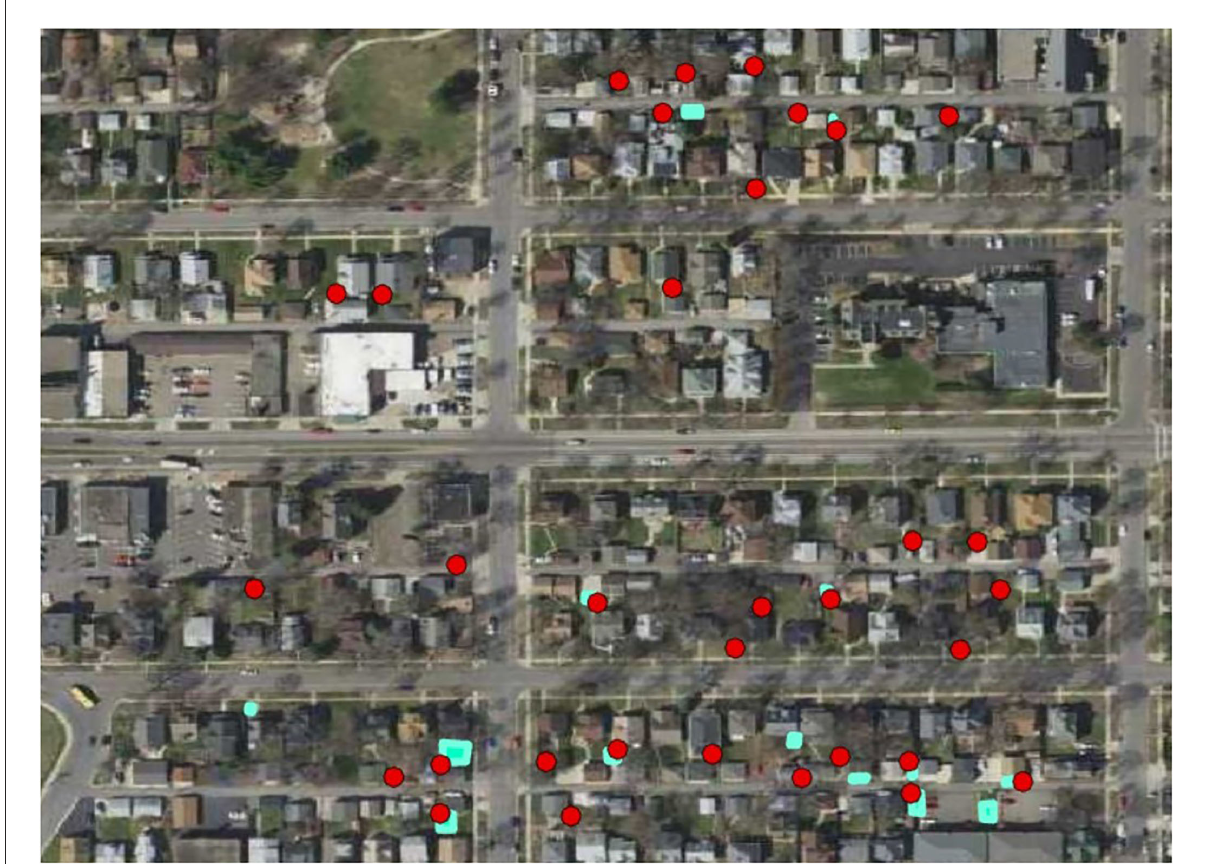
FIGURE4 A sample area in the Twin Cities (Minneapolis and St. Paul, MN, USA) illustrates an increased prevalence in households with an agriculture garden. Household agriculture gardens identified via the hybrid field survey method in the summer of 2017 are marked with blue polygons vs. 2020 as red